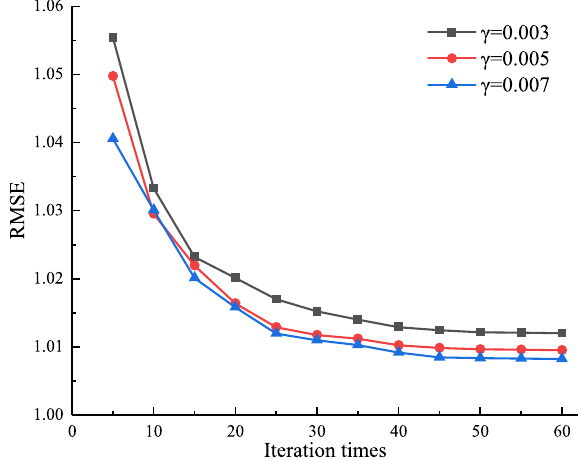
Figure 5. The influence of learning rate γ on the algorithm of this paper.